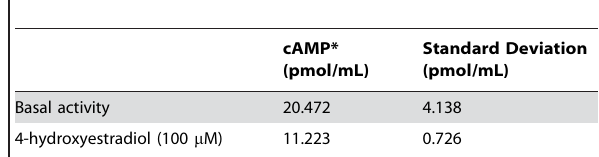
Table 1. sAC activity from Sacy tm1Lex /Sacy tm1Lex brains